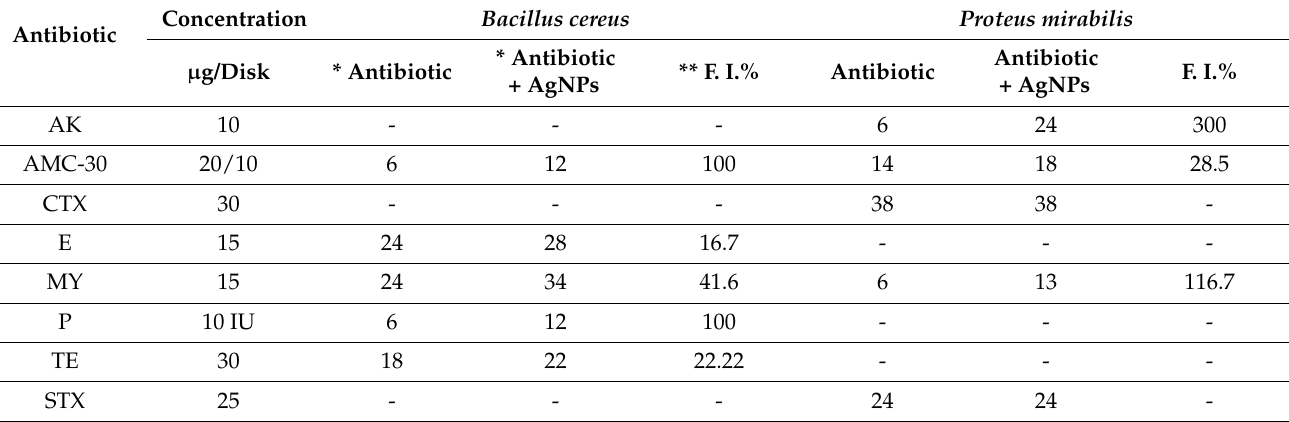
Table 3. Bacterial resistance tests of different antibiotics and antibiotics–AgNPs